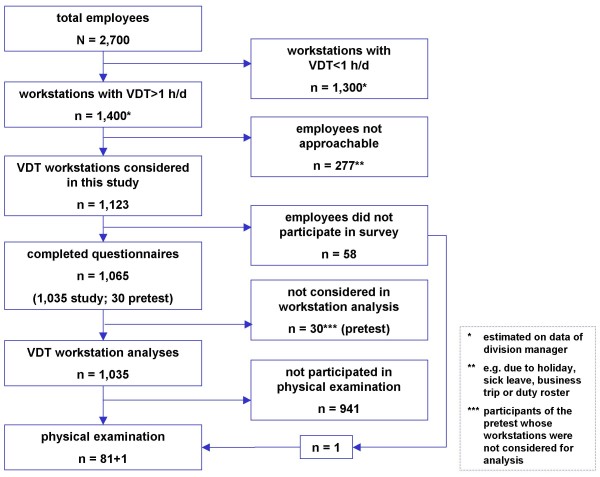
Study participants.